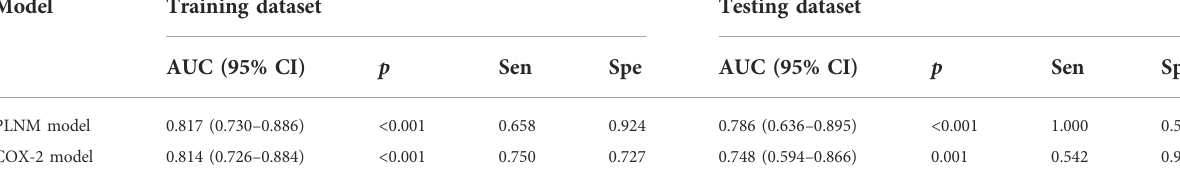
TABLE 2 Evaluation of machine learning model prediction in the training and testing dataset.